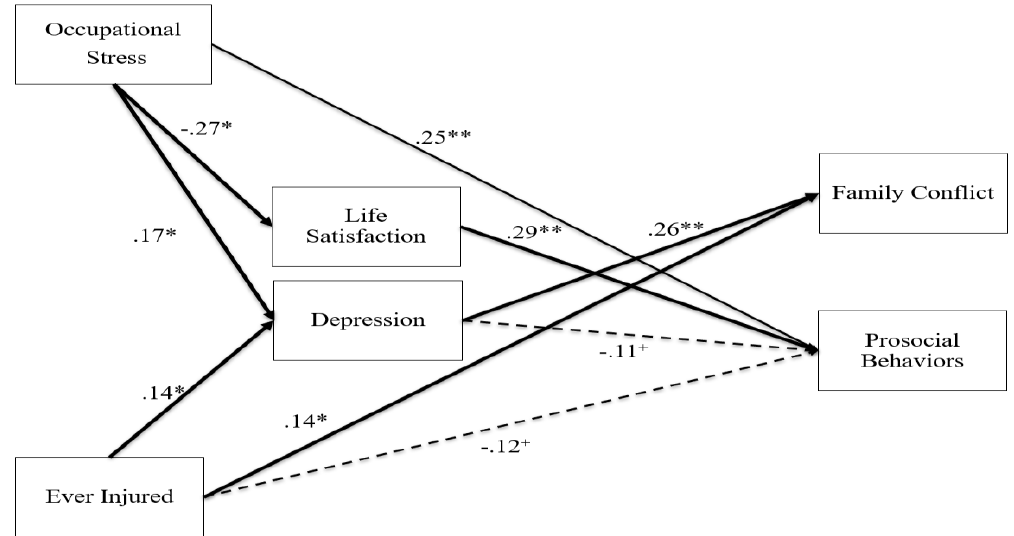
Figure 2. Occupational Stress and Lifetime Injury Predicting Life Satisfaction, Depression, Family Conflict, and Prosocial Behaviors. + p < .10, * p < .05, ** p < .01. Note: The 95% C.I. for all bootstrapped indirect effects, indicated by bolded lines, fell outside of zero. Solid lines represent direct effects, and dashed lines represent paths that approached statistical significance. Nonsignificant paths, the significant covariances among the endogenous variables, and paths including control variables have been omitted from the figure for parsimony.